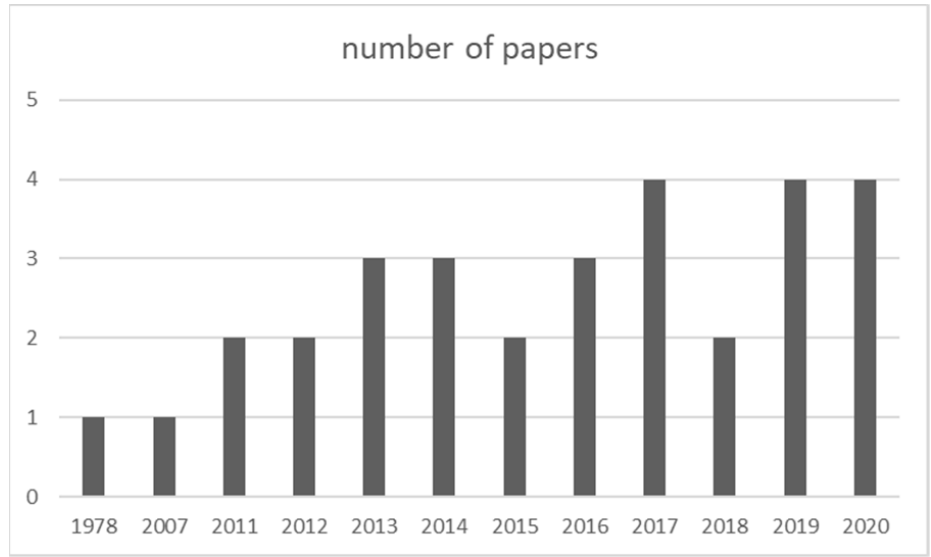
Figure 2. Publishing years of the source studies concerning the affective domain.